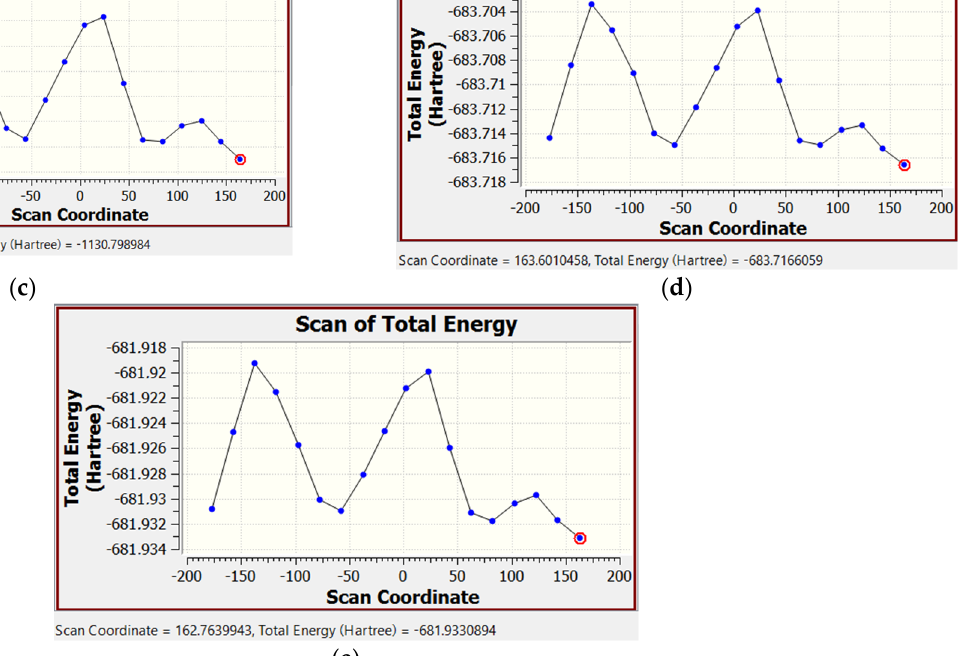
Figure 7. The energy profiles obtained by one-dimensional relaxed scanning the PES on variation in the torsion angle N-CH-C Ar =C Ar for BHFA ( a ), BHFA-oF ( b ), BHFA-oCl ( c ), BHFA-oBr ( d ), and BHFA-oI ( e ) found by the DFT method. At each step, the remaining geometric parameters of the molecules were completely optimized in the M06-2X/6-311+G*/IEFPCM(DMSO) approximation. For halogen derivatives, the profiles were obtained on rotation of the ortho -substituted benzene ring, where the largest, medium (penultimate in heght), and the lowest maxima correspond to a halogen orientation opposite to phenyl, formamide, and methine C-H fragments, respectively. Different heights of maxima in panel ( a ) can be explained by cooperative movements of formamide and two unsubstituted phenyl groups in BHFA molecule on the relaxed PES scan, unlike in BHFA-NMe containing the N-methyl substituent (Figure 5b).